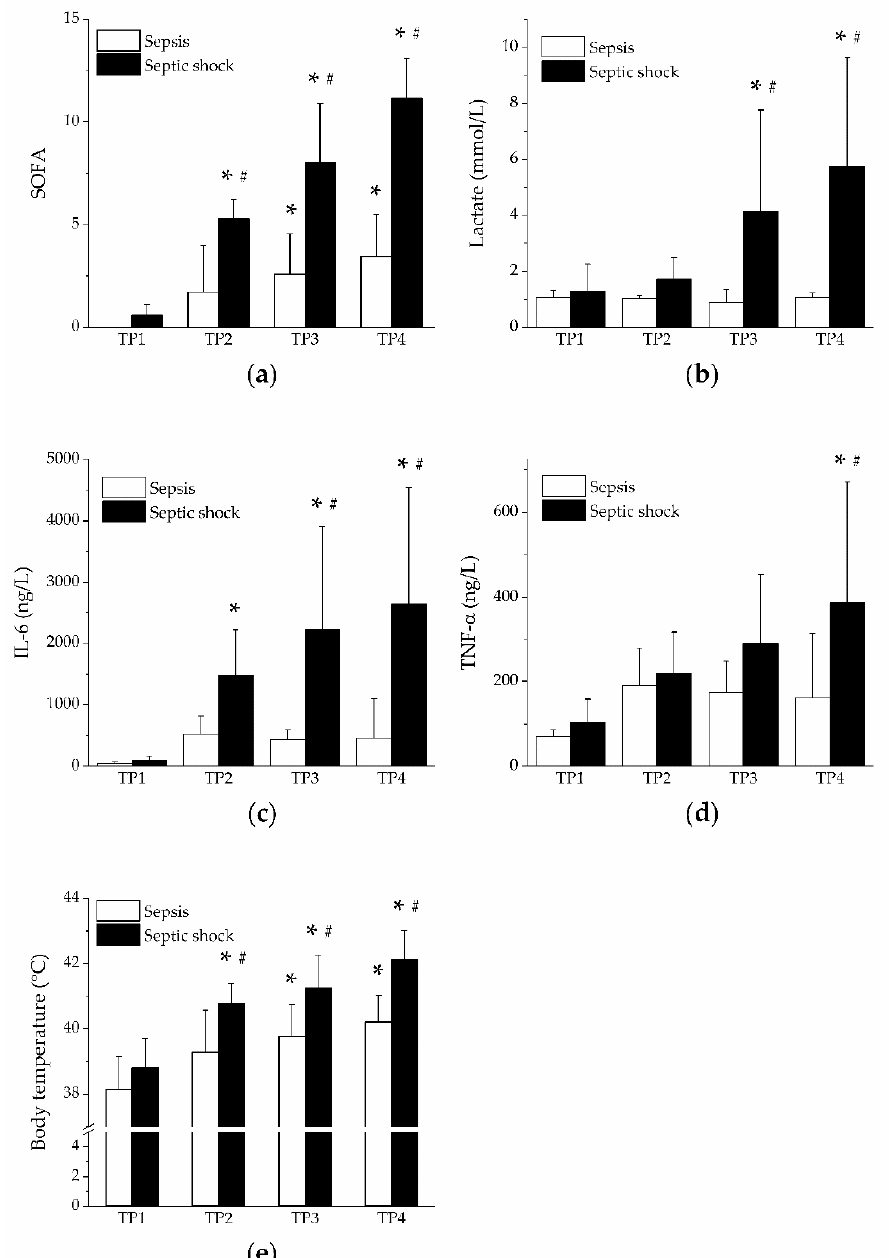
Figure 1. Sequential organ failure assessment (SOFA) score, lactate, cytokines and body temperature. Open columns, sepsis; filled columns, septic shock. *, p < 0.05 vs. baseline (TP1); #, p < 0.05 vs. sepsis. ( a ) SOFA score in sepsis and septic shock; ( b ) plasma levels of lactate in sepsis and septic shock; ( c ) plasma levels of IL-6 in sepsis and septic shock; ( d ) plasma levels of TNF-α in sepsis and septic shock; ( e ) body temperature in sepsis and septic shock.